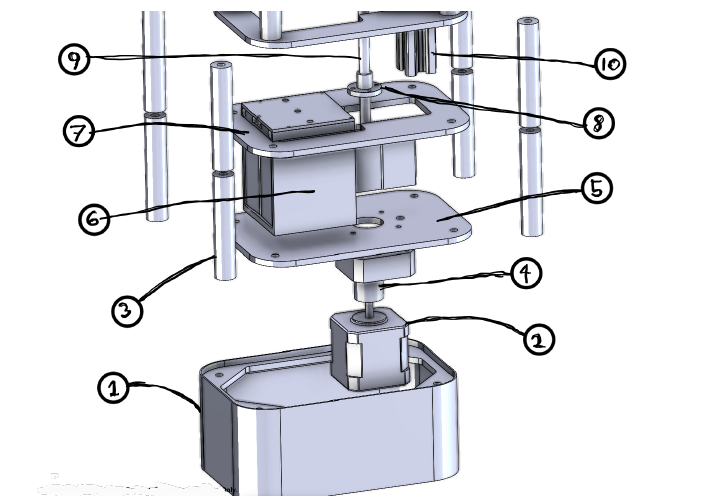
Figure 5. Exploded view of the elevator model: (1) Bottom skirt, (2) Stepper motor, (3) Tube spacer, (4) Flex axle, (5) Bottom floor, (6) Cabin + Cabin door setup, (7) Mid floor, (8) Lead nut, (9) Threaded rod, (10) V-slot RatRig